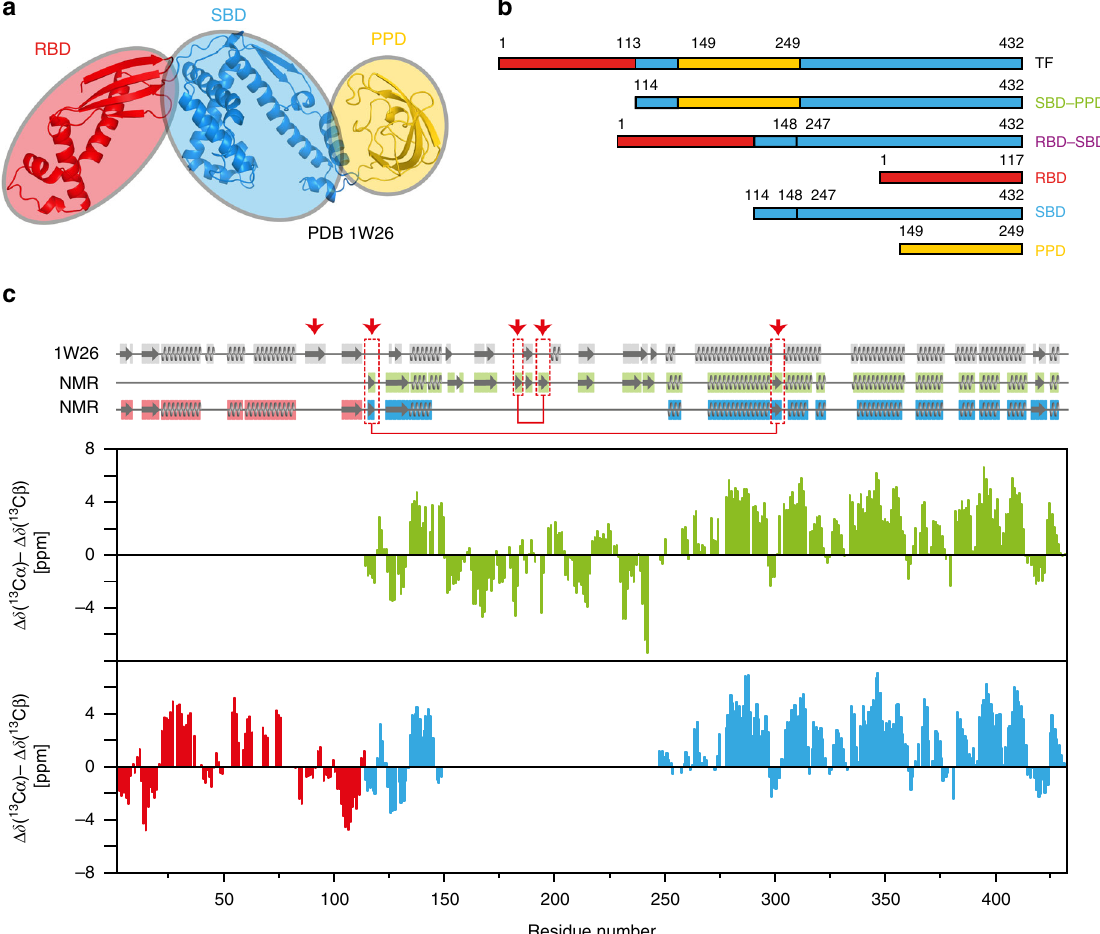
Fig. 1 Domain organization of full-length TF and secondary structure elements in solution. a On the ribbon representation of a published TF crystal structure (PDB 1W26 8 ), the three domains ribosome-binding domain (RBD), substrate-binding domain (SBD), and peptidyl-prolyl- cis / trans isomerase domain (PPD) are colored in red, blue, and yellow, respectively. b Domain constructs of E. coli TF used in this work. Six constructs of TF domains are shown with amino acid numbering corresponding to full-length TF. The names de fi ne a color code used throughout this work. c Secondary 13 C chemical shifts plotted against the amino acid residue number of TF, as determined from triple-resonance experiments in the domain constructs SBD – PPD (green), RBD (red), and SBD (blue). A 1 – 2 – 1 weighting function for residues ( i − 1) – i – ( i + 1) has been applied to the raw data to reduce noise and highlight regular secondary structure elements. Secondary structure elements were calculated for the crystal structure (PDB 1W26, gray) with DSSP 12 and for the NMR data with CSI 3.0 13 and are indicated on top. The red arrows and boxes highlight structural elements detected only in